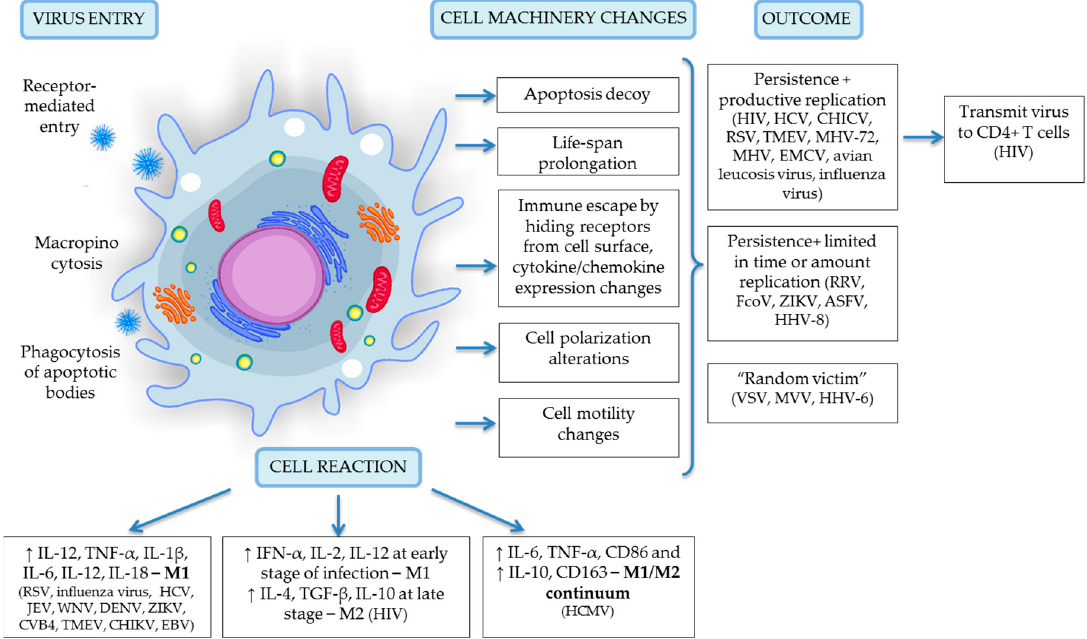
Figure 1. A schematic representation of virus entry, cell reaction and machinery changes and viral outcome upon infection specific for the monocyte/macrophage system. Details of depicted interactions are discussed in detail in the text above.